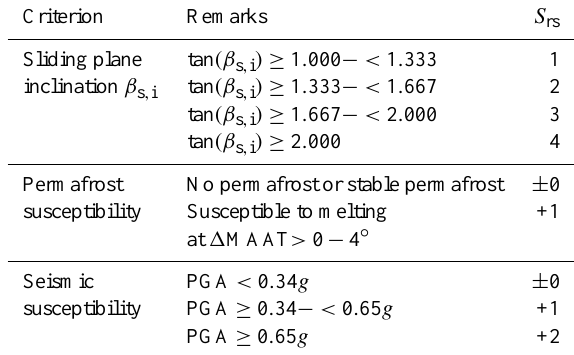
Table 5. Rock slide susceptibility score S rs . The initial values of S rs are determined from the sliding plane inclination β s , i , these values are then increased according to permafrost susceptibility and seis- mic susceptibility, g is gravity (ms − 2